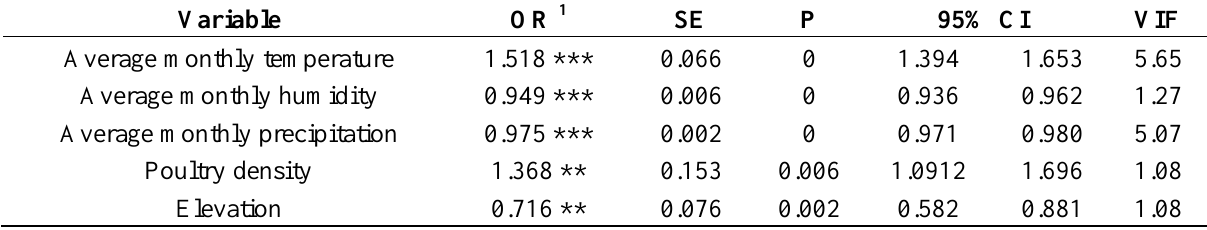
Table 2. Logistic regression model of HPAI H5N1 in the Red River Delta, Vietnam.